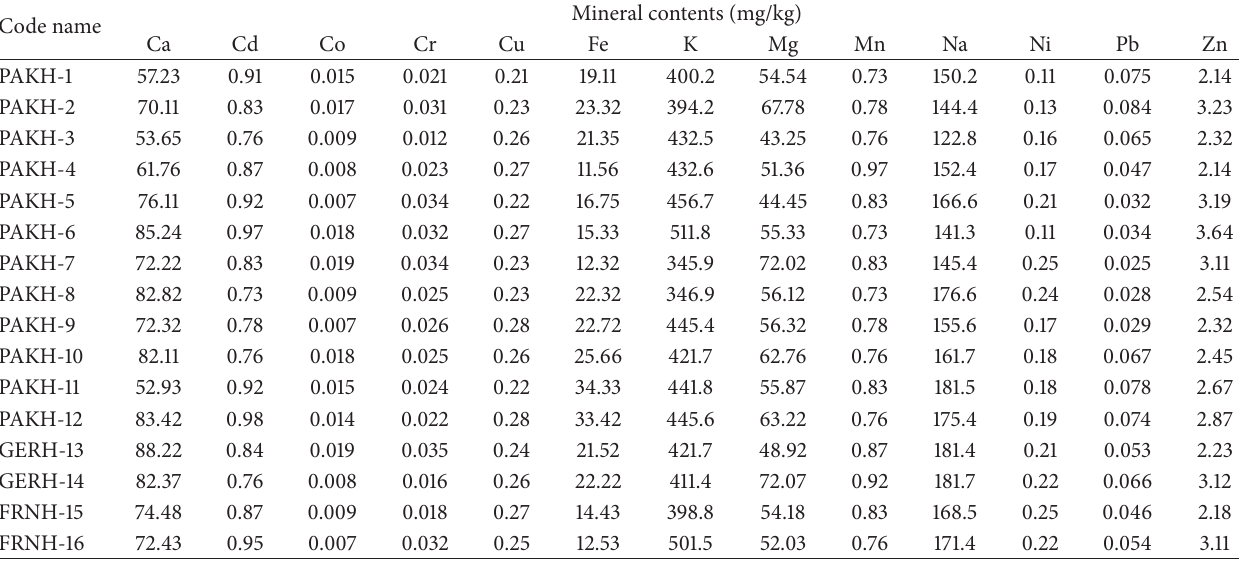
Table 4: Mineral contents in sixteen honey samples produced in Pakistan and two other countries samples.